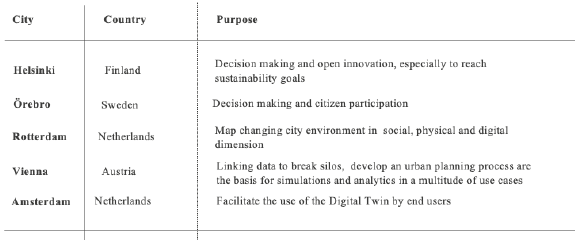
Table 1. Selection of Urban Digital